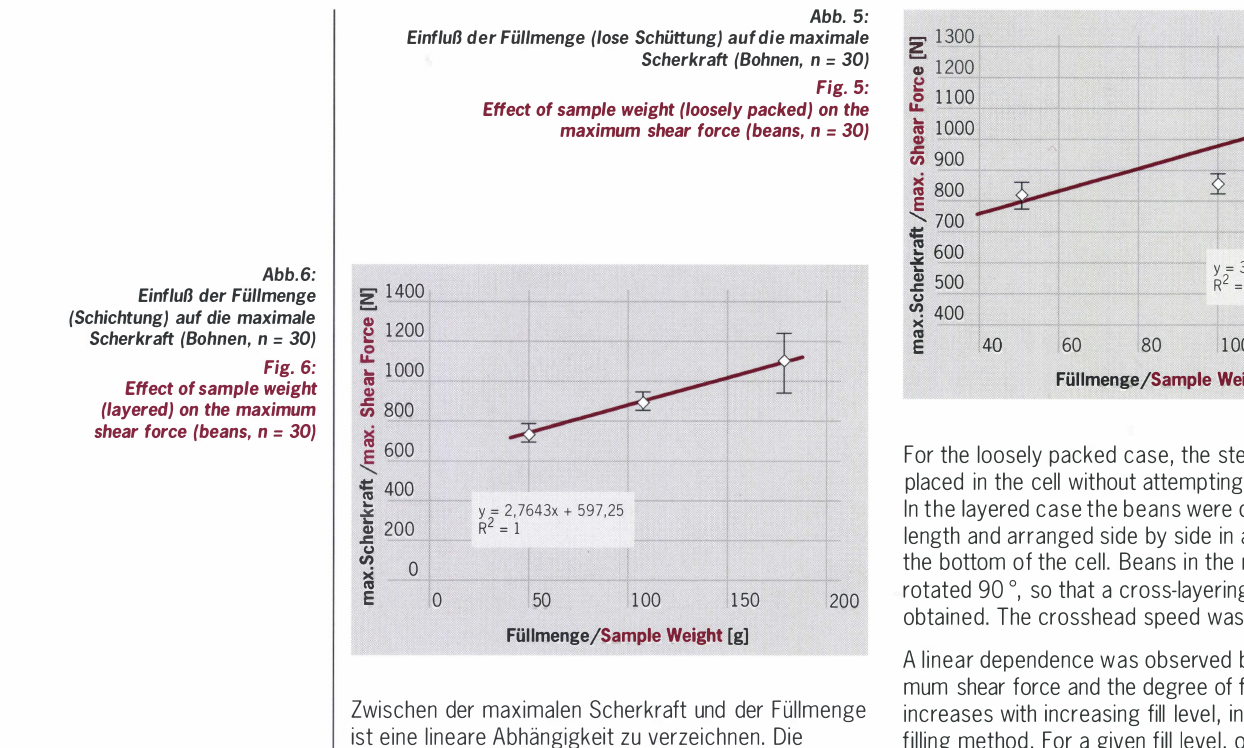
Abb.6: Einflufl der Fiillmenge